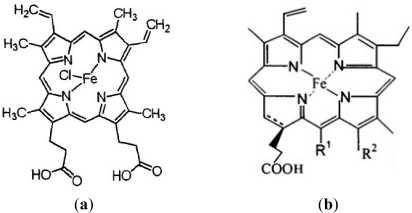
Structure of (a) hemin; and (b) Fe-chlorophyllin. R1 = H, CH3 or CH2COOH; R2 = COOH; or R1, R2 = –CH(COOH)C(O)–.